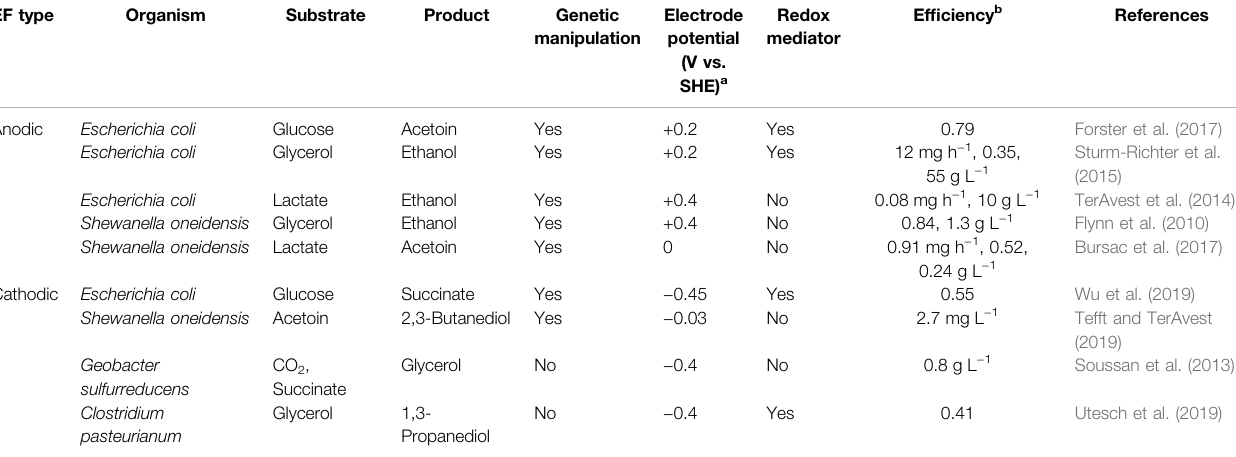
TABLE 1 | Studies examining the utility of EF for the production of value-added